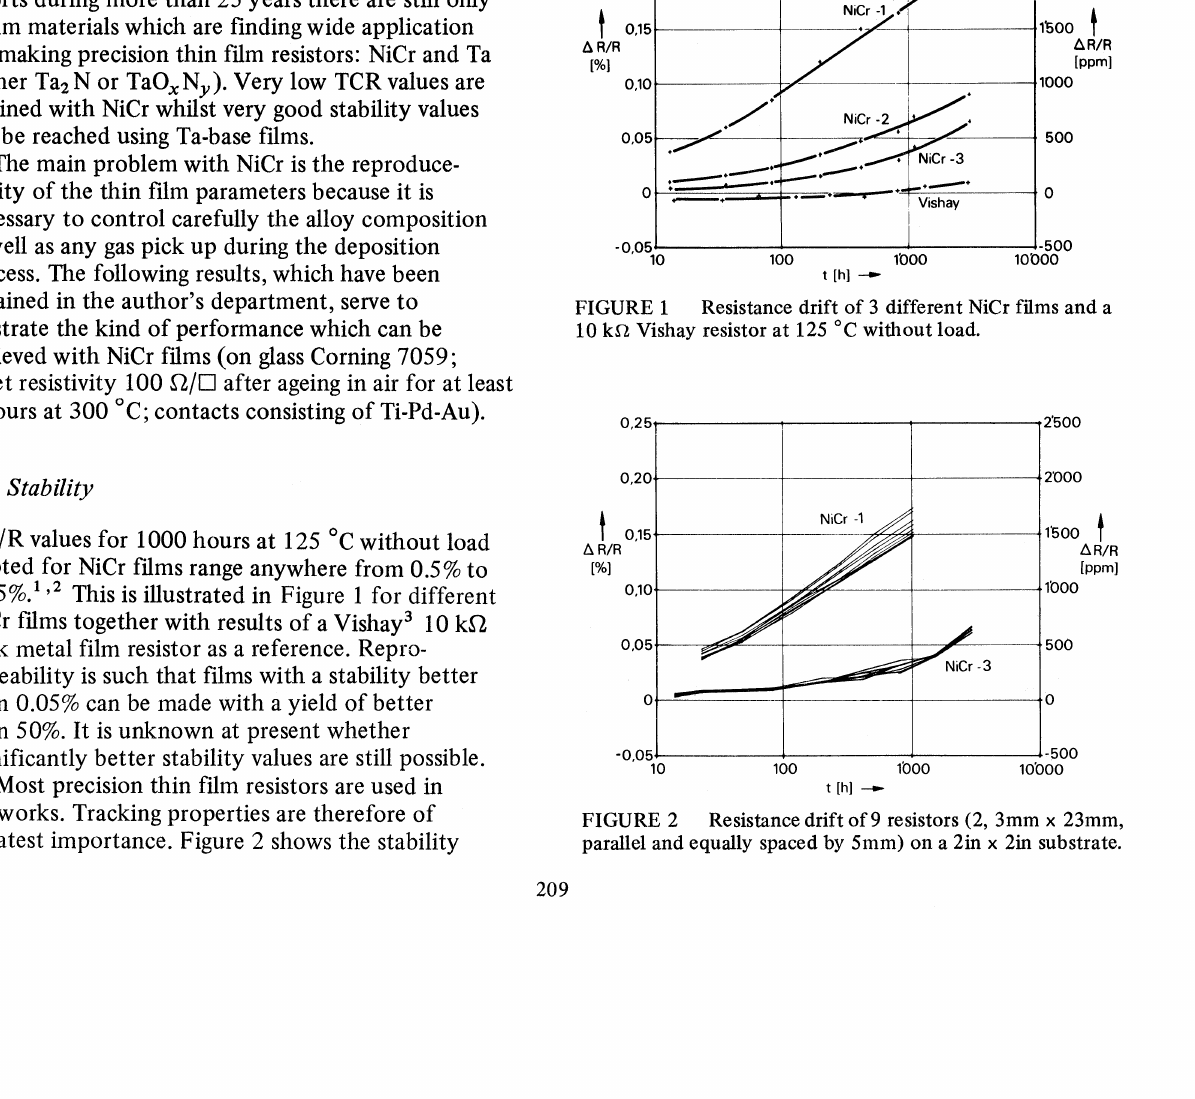
Resistance drift of 9 resistors (2, 3mm x 23mm, parallel and equally spaced by 5mm) on a 2in x 2in